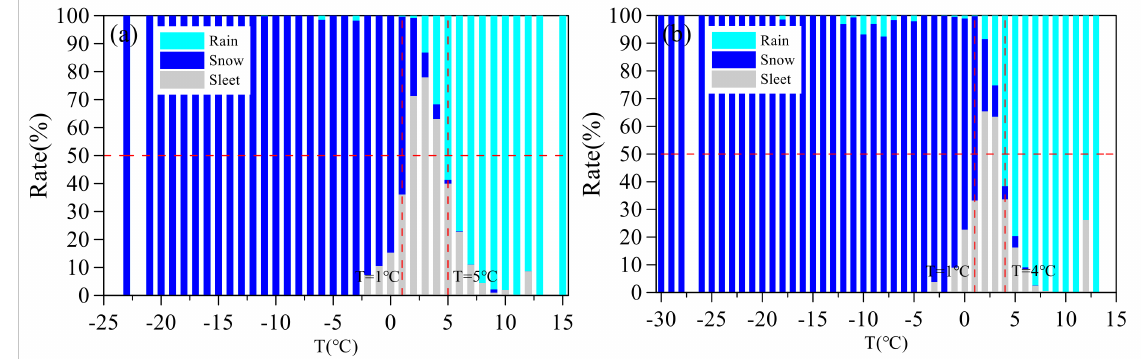
Figure 2. Snow, sleet, and rain distribution along with air temperature; ( a ) Jimai station, ( b ) Maduo station.